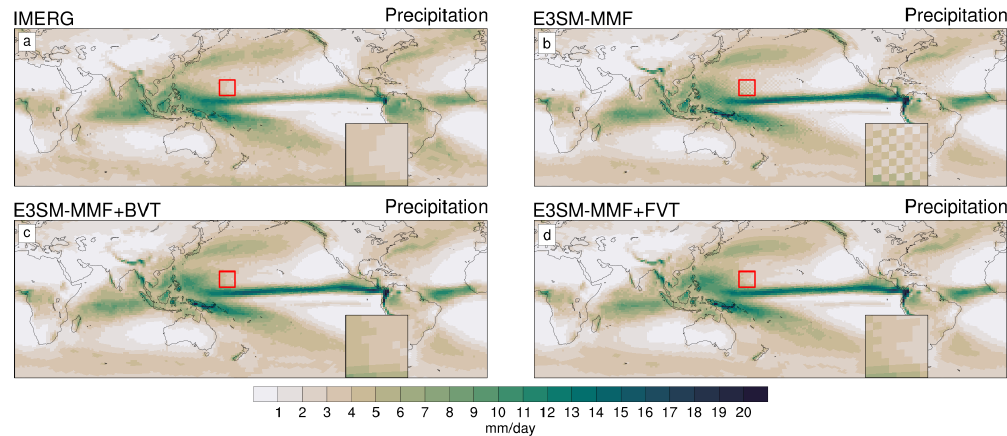
Figure 1. Maps of 10-year mean precipitation for using data from Integrated Multi-satellite Retrievals for GPM (IMERG) (a) , E3SM-MMF (b) , E3SM-MMF with bulk variance transport (BVT, c ), and E3SM-MMF with filtered variance transport (FVT, d ). The red outline indicates the region shown in the inset map that highlights a region that typically has a noticeable checkerboard pattern in E3SM-MMF without variance